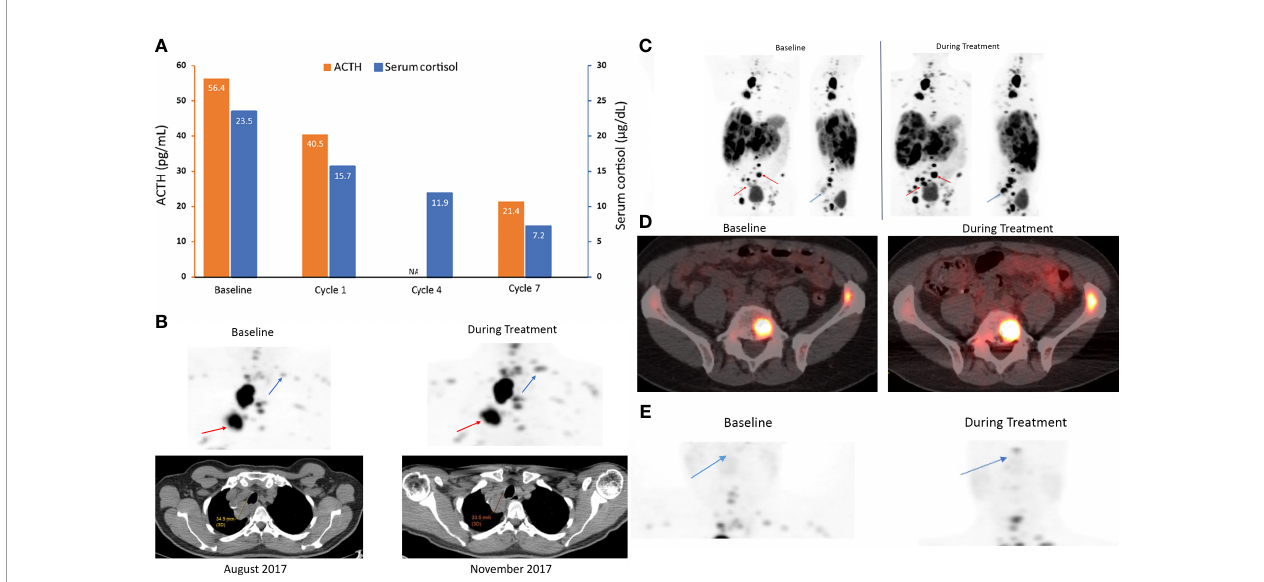
FIGURE 4 | ACTH and serum cortisol levels (A) and 68 Ga-DOTATATE scans (B – E) in case 2: a 68-year-old man with a metastatic carcinoid NET treated with 7 cycles of relacorilant + nab-paclitaxel. (A) ACTH and cortisol levels before (baseline) and during relacorilant + nab-paclitaxel treatment. Patient received concomitant somatostatin analog. Normal laboratory ranges: ACTH, 6-50 pg/mL; morning serum cortisol, 4.6-20.6 µg/dL. To convert ACTH values from pg/mL to pmol/L, multiply by 0.22. To convert serum cortisol from µg/dL to nmol/L, multiply by 27.6. (B) 68 Ga-DOTATATE scan showed multiple lung and bone lesions at baseline before treatment with relacorilant. Repeat scan during treatment with relacorilant showed increased uptake without change in size of the lesions on CT. (C) 68 Ga DOTATATE scan showed multiple lung, liver, and bone lesions at baseline before treatment with relacorilant. Repeat scan during treatment with relacorilant showed increased uptake. (D) 68 Ga DOTATATE scan of L5 and left iliac bone lesions at baseline. Repeat scan during treatment with relacorilant showed increased uptake. (E) Compared with the 68 Ga-DOTATATE scan before treatment with relacorilant, the repeat scan during relacorilant treatment showed increased uptake at the pituitary gland. ACTH, adrenocorticotropic hormone; NA, not available.